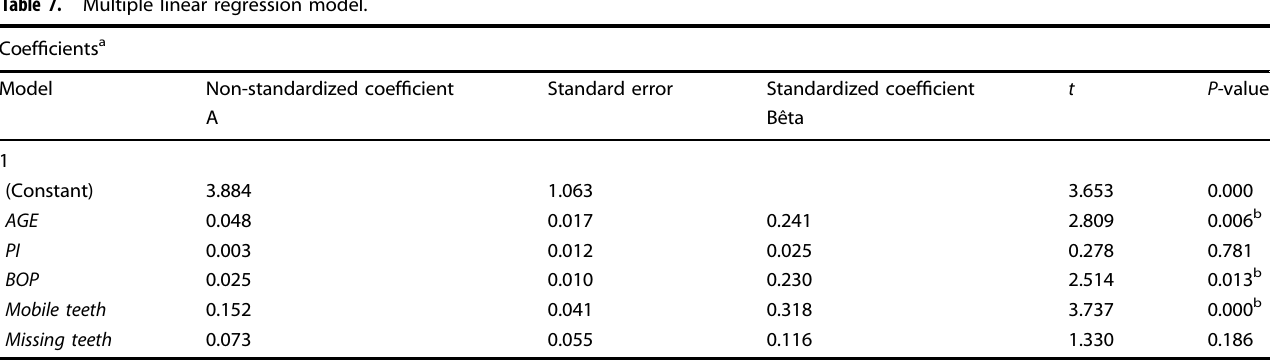
Table 7. Multiple linear regression